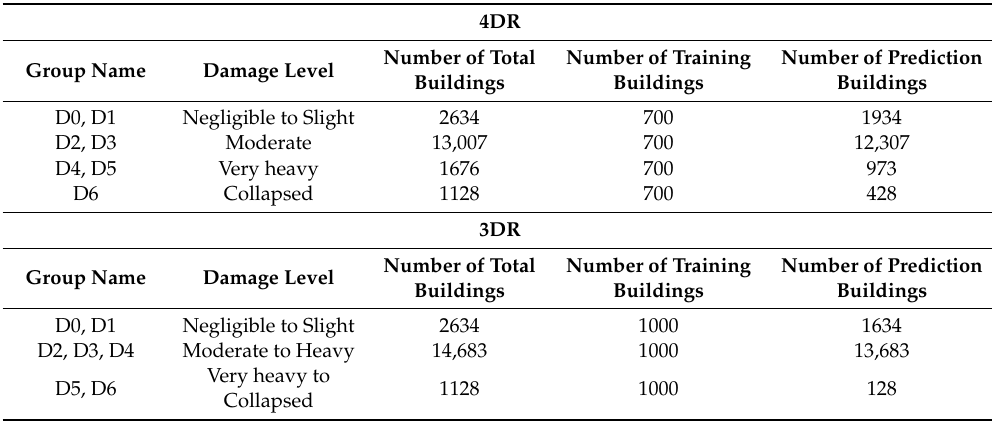
Table 2. The number of structures in the study area and the number of structures intended for training and prediction in 3 and 4 rate of